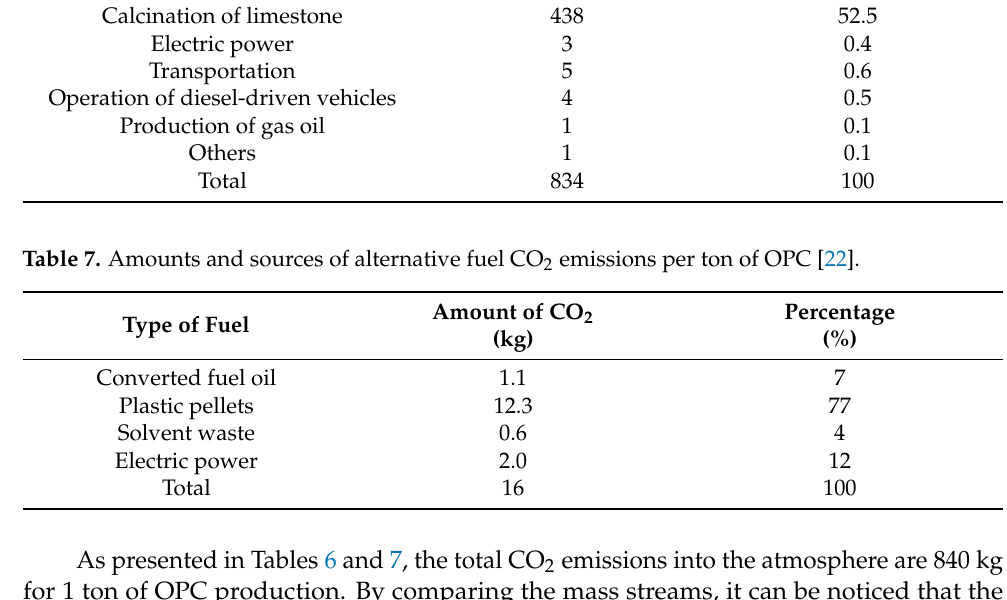
Table 6. Amounts and sources of fossil fuel CO 2 emissions per ton of OPC [22]. Amount of CO 2 Percentage Process (kg) (%) Combustion fuels in the kiln